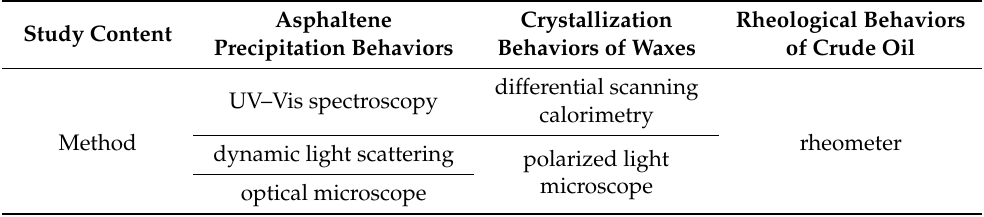
Table 2. Methodology of the study on the asphaltene precipitation and wax crystallization by